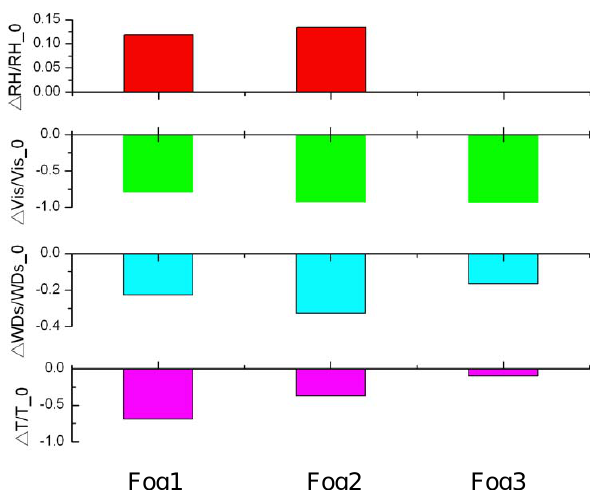
Fig. 6. The anomalies of the visibility, surface temperature, relative humidity, and surface wind speed during the three fog period to the averaged value of the